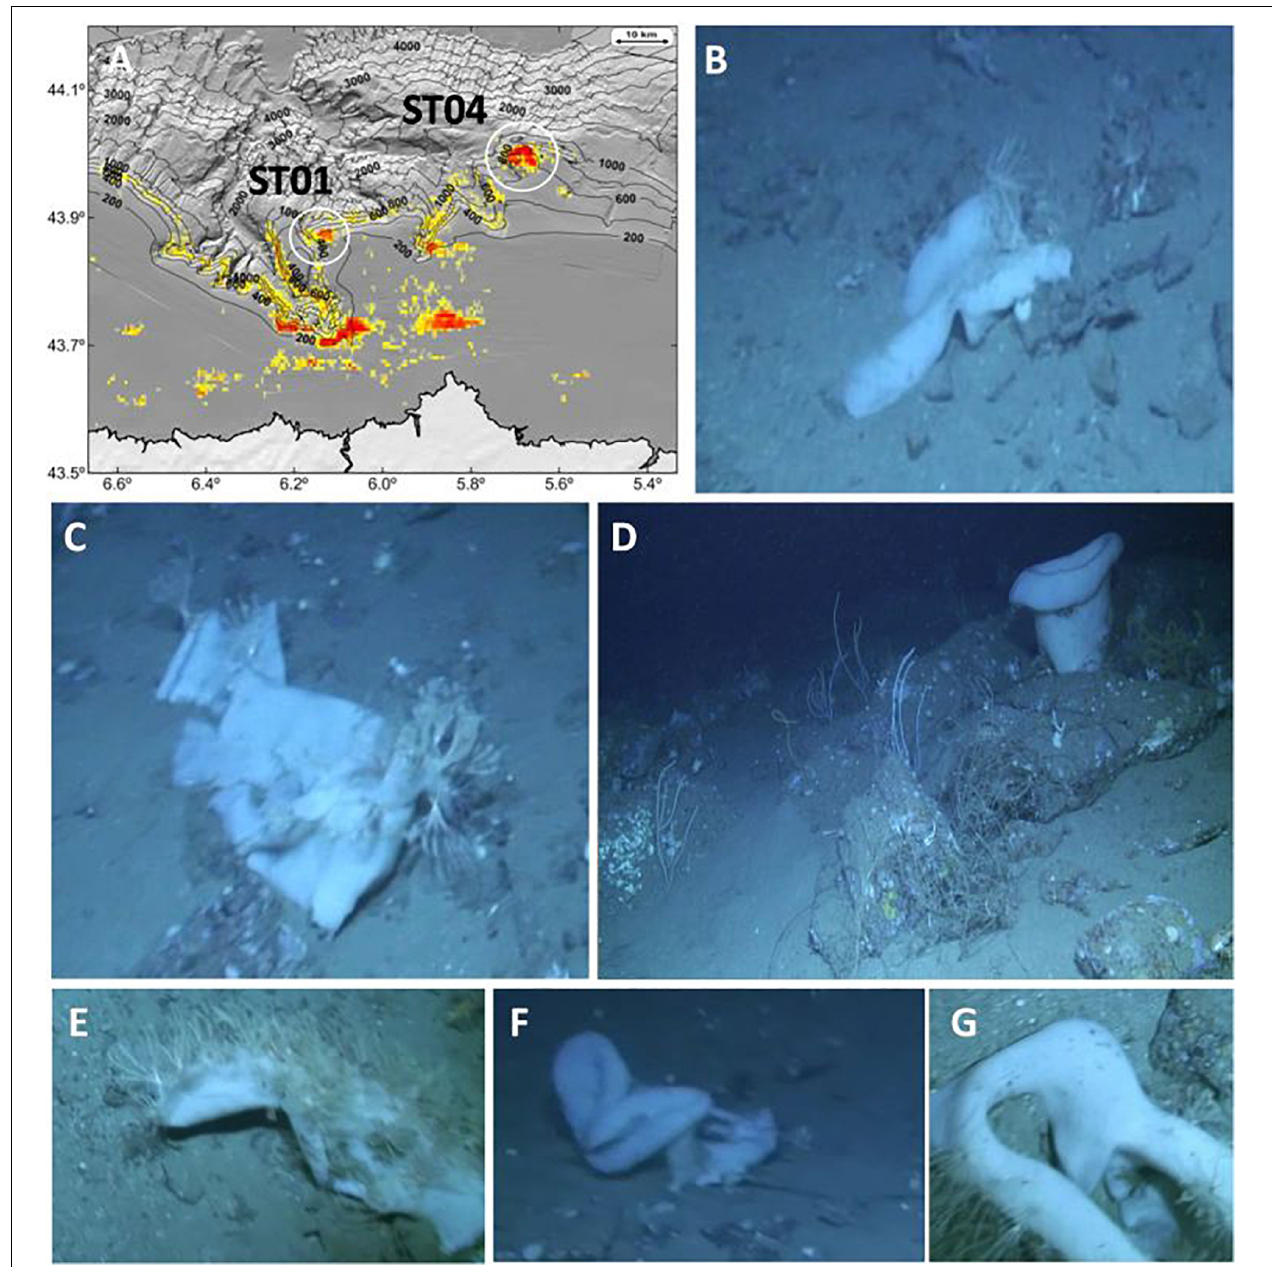
FIGURE 8 | Fishing effort of longliners (A) and some of the specimens of A. setubalense damaged by longlines and gillnets in the area ST01 (B–G)